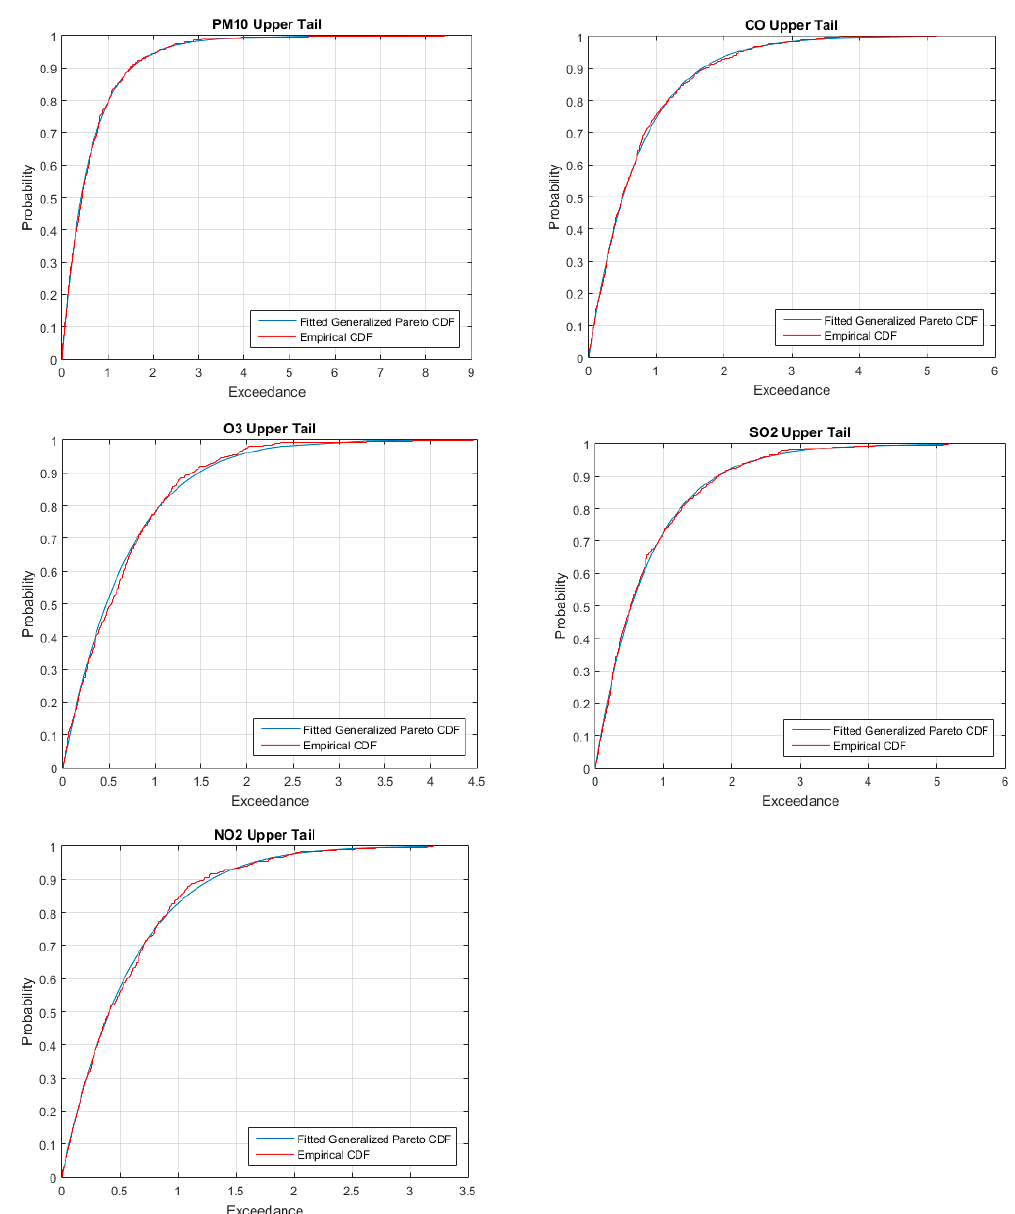
Figure 3. Fitted generalized Pareto distribution (GPD) model of the upper tail distributions for each pollutant variable.